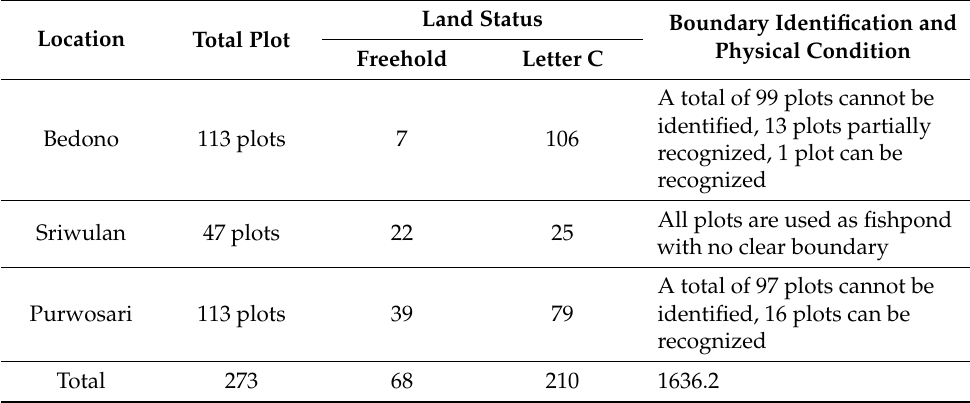
Table 2. Land status and boundary identification per